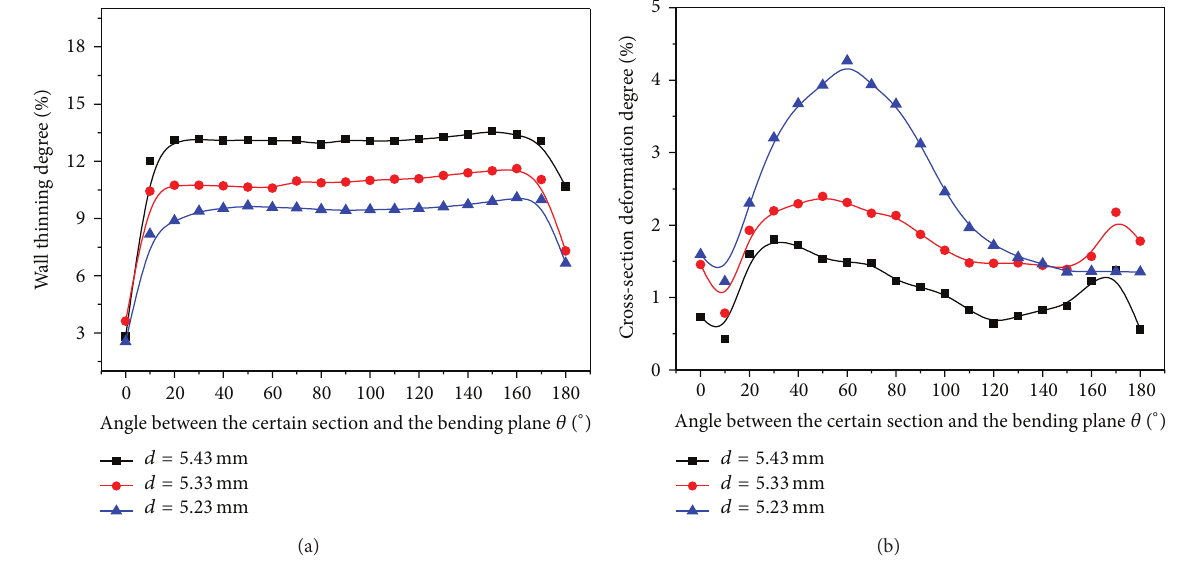
Figure 8: Effect of mandrel diameter on cross section quality: (a) wall thinning; (b) cross section